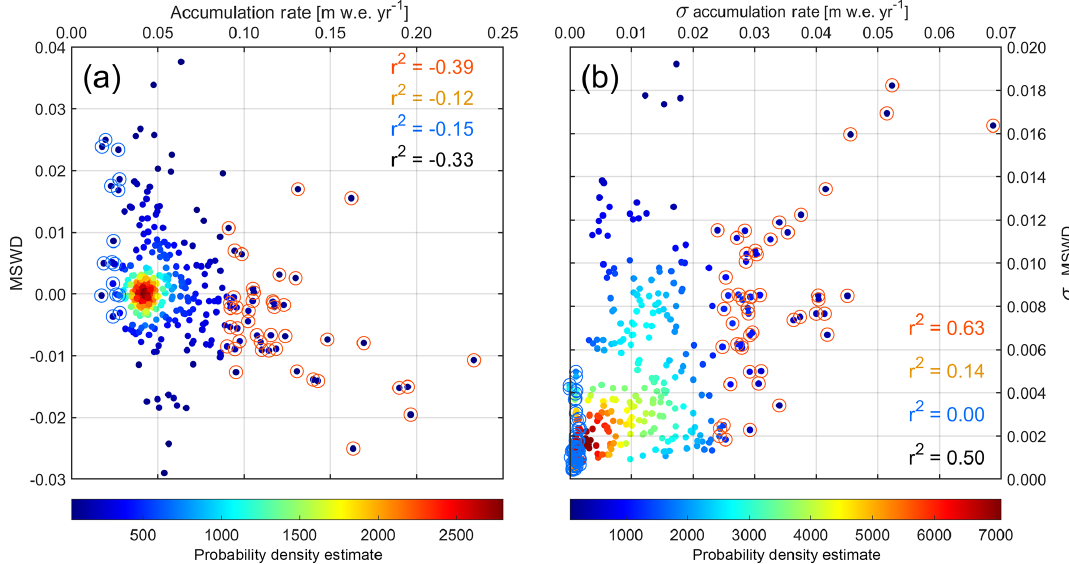
Figure 7. (a) Mean slope in the mean wind direction (MSWD) versus snow accumulation rate around 88 ◦ S in 1 ◦ longitude bins (4km). Since monochrome scatter plots can be misleading, we have used color coding to indicate regions with higher point density. Higher probability density estimates, calculated using a kernel estimate, are shown in warmer colors and indicate regions with higher point density. The prob- ability density estimate is for visual clarity only and is not used for analysis or interpretation. Pearson’s correlation coefficient r 2 = − 0 . 33 for the entire data set. (b) Same for the standard deviation σ of the MSWD and snow accumulation rate with r 2 = 0 . 50. σ is estimated over 20km long moving windows. Data points below µ − σ are indicated with blue circles and r 2 values are listed in blue. The upper subset consists of data points above µ + σ and is marked by red circles and red r 2 values. The remaining data points fall within ± σ from µ , with r 2 shown in orange (data points are not marked for clarity).